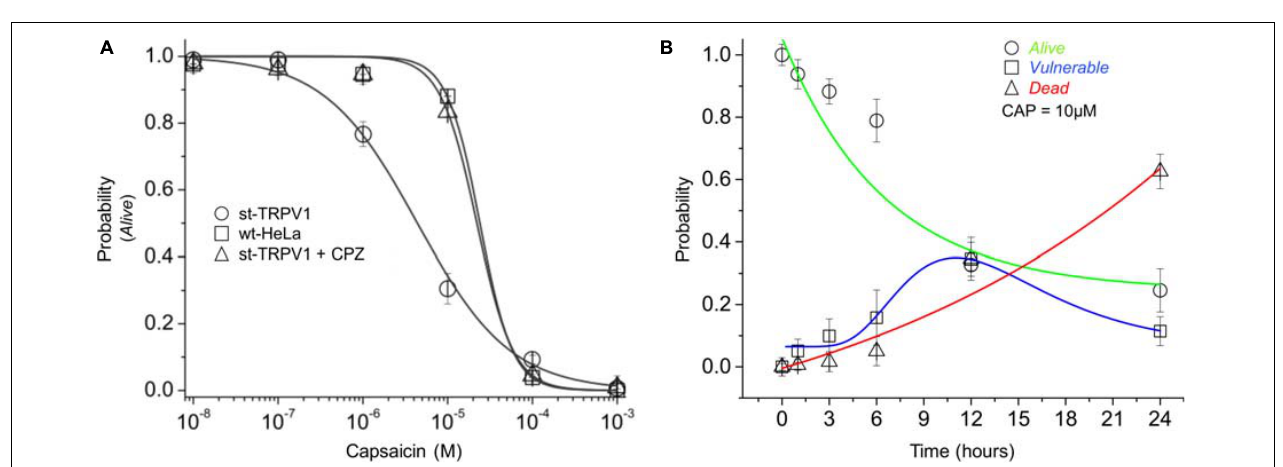
FIGURE 3 | Dose- and time-response of CAP-induced cell death. (A) Probability of cell state A ( P A ) of wt-HeLa cells and st-TRPV1 HeLa cells in the presence or absence of 10 µ M CPZ exposed to several concentration of CAP (1 · 10 − 3 to 1 · 10 − 8 M) for 24 h. (B) Probability of cell state progression of st-TRPV1 HeLa cells exposed to 10 µ M CAP for 0, 1, 3, 6, 12, and 24 h. Data are shown as mean ± SEM ( n = 5). ∗ p <